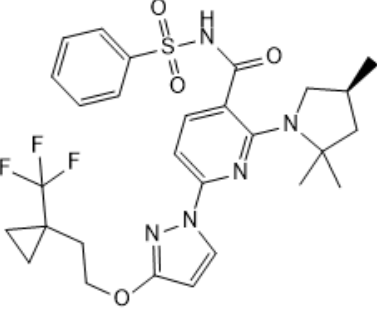
Figure 7. Chemical structure of Bamocaftor.